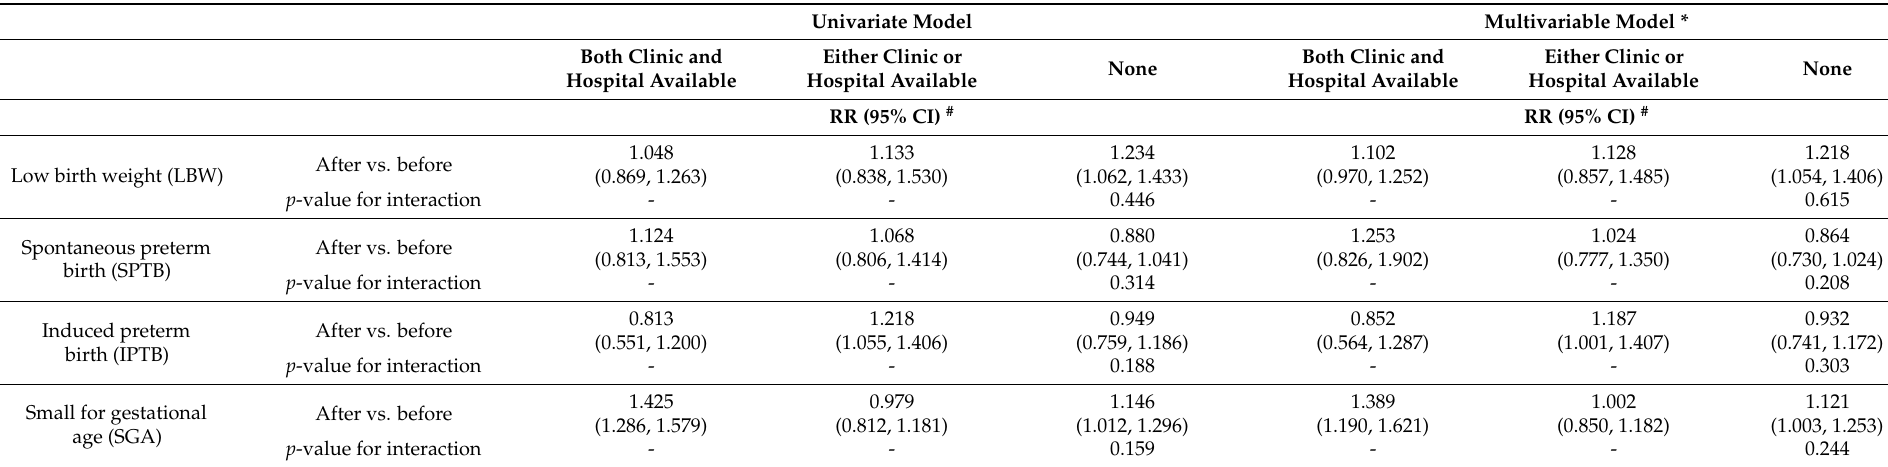
Table 3. Changes in perinatal outcomes after Hurricane Michael by maternity care availability within Area A &